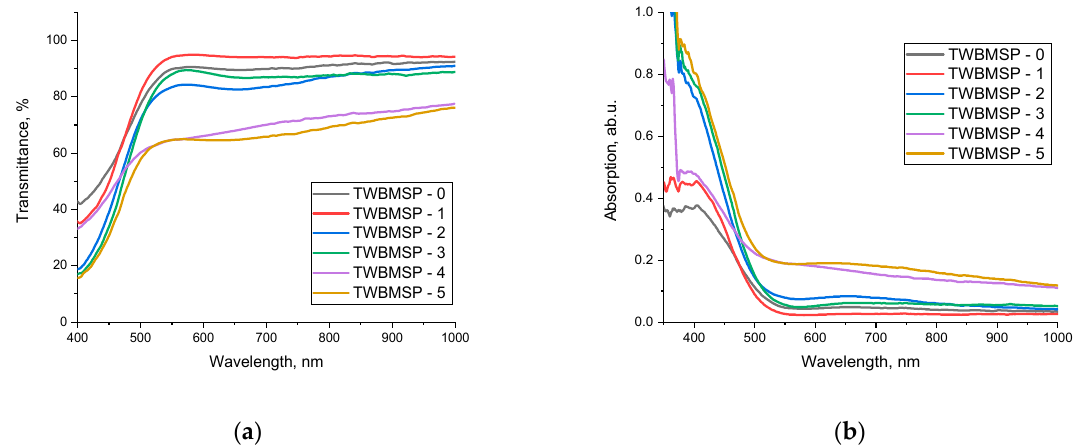
Figure 6. Results of the optical properties of samples under study: of the optical properties of the samples under study: ( a ) optical transmission spectra; ( b ) optical absorption spectra.